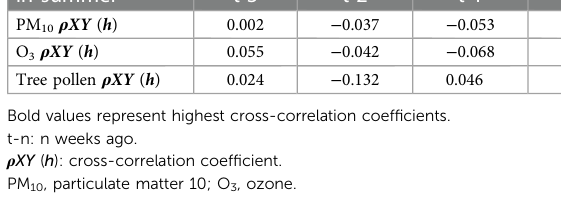
Bold values represent highest cross-correlation coef fi cients. t-n: n weeks ago. TABLE 2 Cross-correlation coef fi cients between the number of asthma exacerbations (t) and atmospheric substance (t-n) in summer. In summer